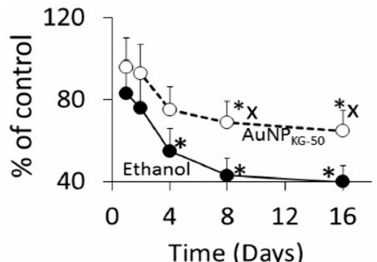
AuNP PEG +KG, 7: AuNP KG-37 , 8: AuNP PEG , 9: AuNP G-50,G90 .